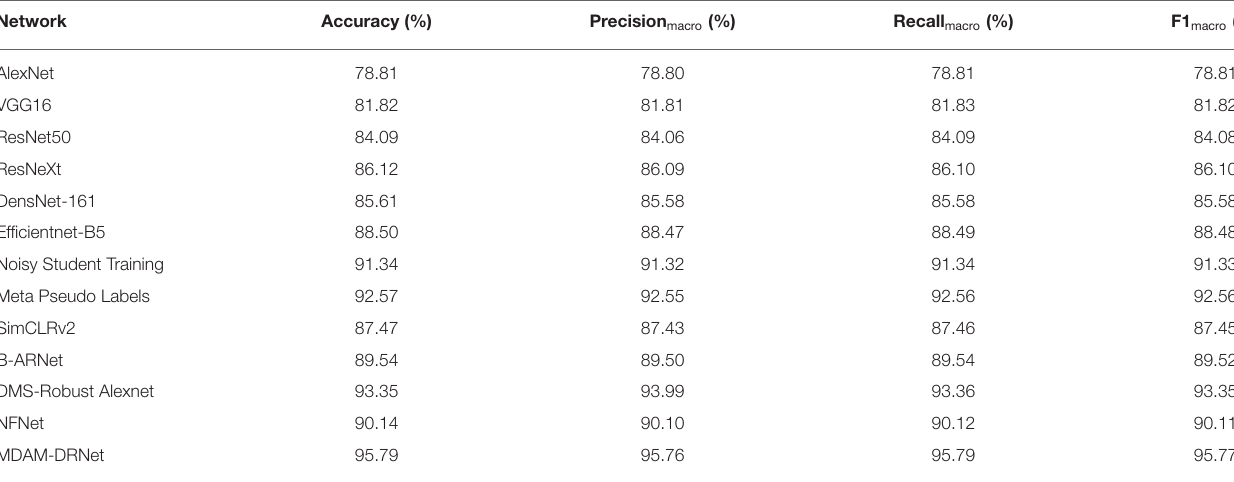
TABLE 9 | Test results of 13 models on the same strawberry leaf disease data set. Network Accuracy (%) Precision macro (%) Recall macro (%) F1 macro